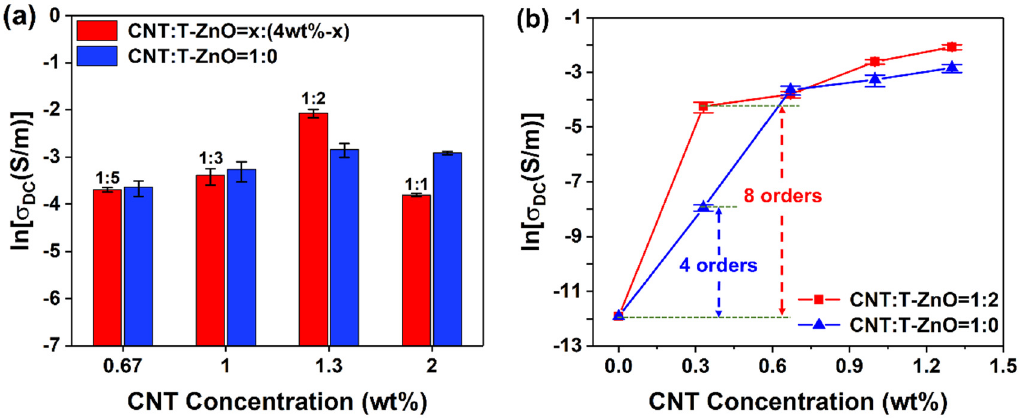
Figure 4: ( a ) In fl uence of mixing ratio on electrical conductivities of epoxy nanocomposite with and without T - ZnO; ( b ) electrical properties of pristine CNTs/epoxy, CNTs:T - ZnO ( 1:2 ) /epoxy under di ff erent nano fi ller